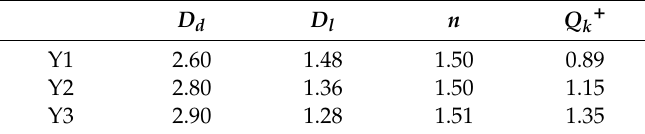
Figure 6. Pore size distribution simulation process. Table 3. Fractal results based on pore size distribution